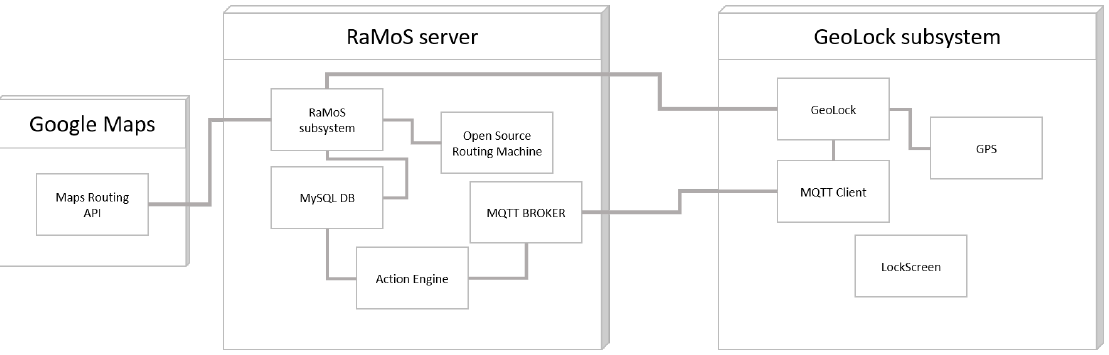
Figure 2. Overall summarized system architecture.